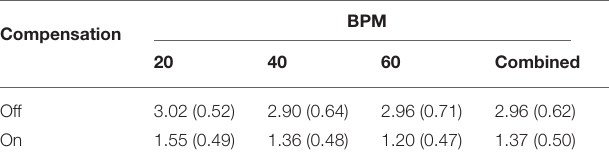
TABLE 1 | RMS of human-robot interaction forces ( N ) during continuous finger flexion and extension movements at different frequencies. Compensation